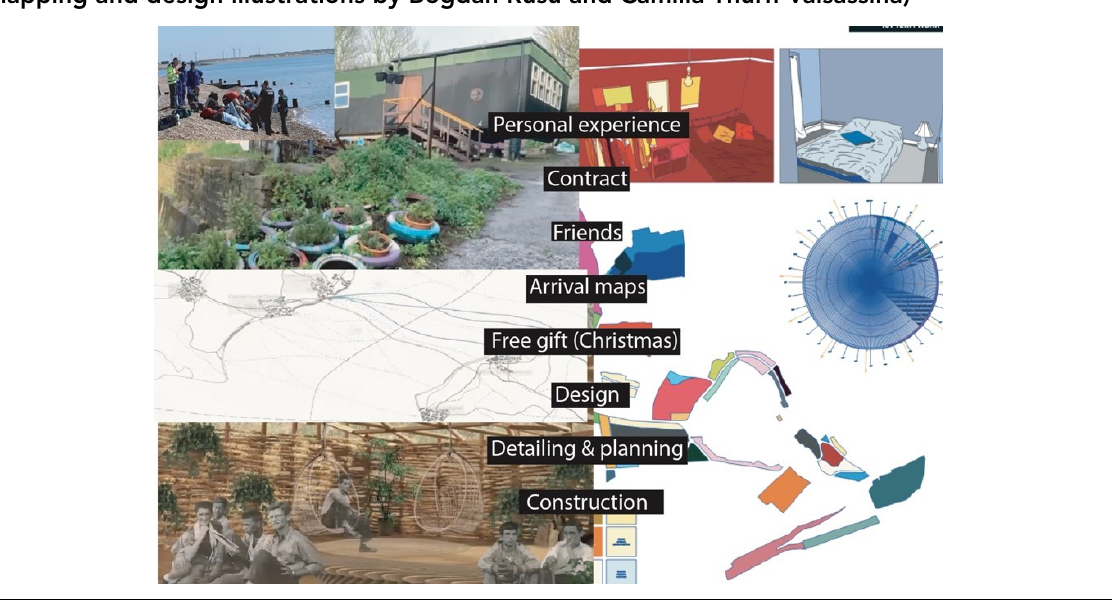
Figure 2. Global Free Unit project phases (Source: photo composition by Peter Hemmersam; mapping and design illustrations by Bogdan Rusu and Camilla